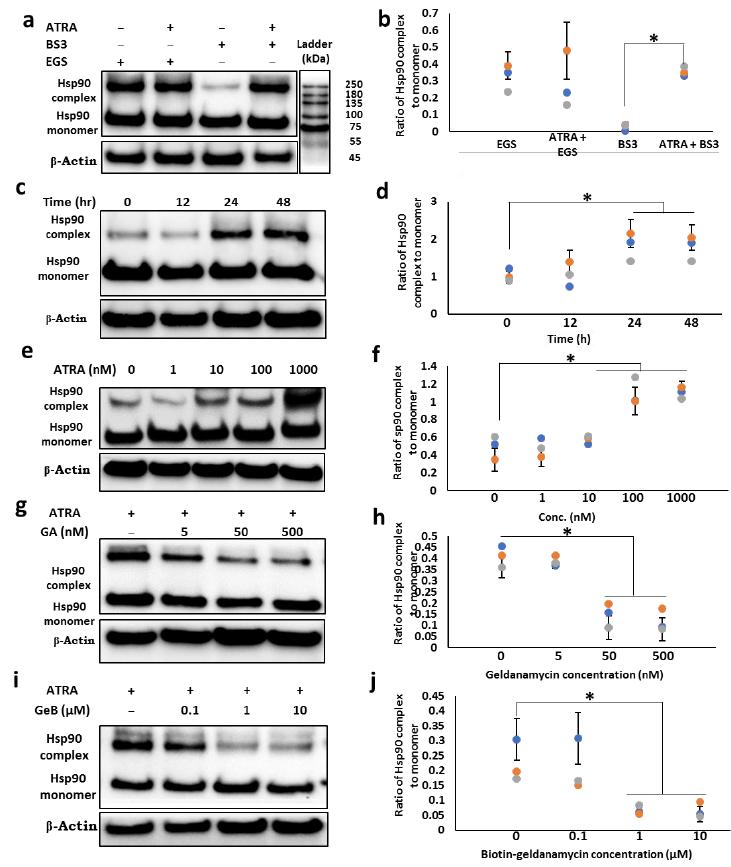
Figure 2. ATRA enhances the cell surface Hsp90α complex formation. ( a , b ) Detection of Hsp90 com- plex using either cell impermeable cross-linker BS3 or permeable cross-linker EGS. ( c – j ) Cell surface Hsp90 complex in different experimental conditions. THP-1 cells were treated with 1 µM ATRA for 24 h ( a , b ) or with 1 µM ATRA for different time periods ( c , d ), with different concentrations of ATRA for 24 h ( e , f ) or in the presence of Hsp90 permeable inhibitor ( g , h ) or Hsp90 impermeable inhibitor ( i , j ). The cells were then incubated with either 2.5 mM EGS ( a , b ) or 2.5 mM BS3 ( a – j ) for 30 min. After the cross-linking reaction, the collected lysate was analyzed by immunoblotting with an anti- body against Hsp90. ( b , d , f , h , j ) Densitometric analysis of the protein bands was performed using the ChemiDoc MP Imaging System (n = 3). The ratios of Hsp90 oligomers to monomers were calcu- lated, and data were normalized to the control condition (DMSO). The ratio of oligomer/monomer in the control group was set to 100%. Statistical analyses were performed between the control and treated groups; * p < 0.05.